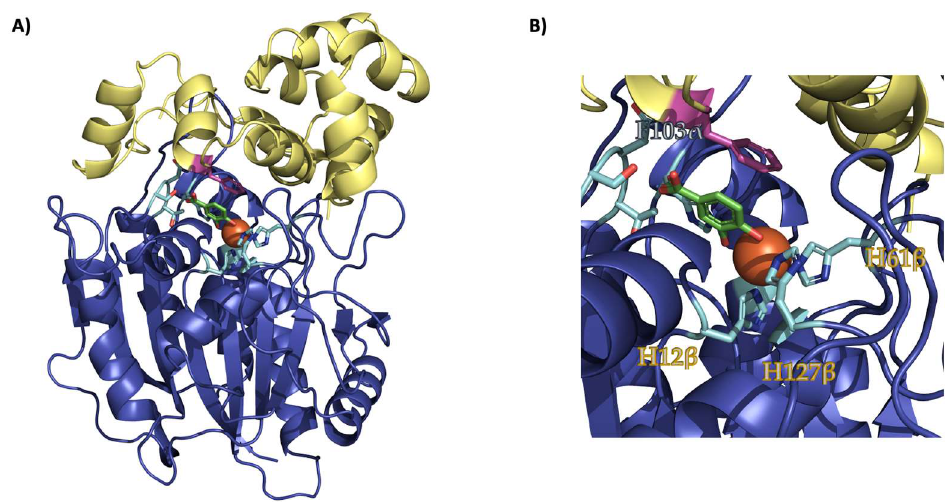
Figure 2. The interface complex of LigAB with Fe(II) and PCA bound. ( A ) The heterodimer LigAB (PDB: 1B4U) with LigA in yellow, LigB in blue, the active site residues in cyan, F103 in pink, PCA in green, and Fe(II) in orange. ( B ) A close-up of the active site with the active site, which illustrates the proximity of F103α to the coordinated substrate.